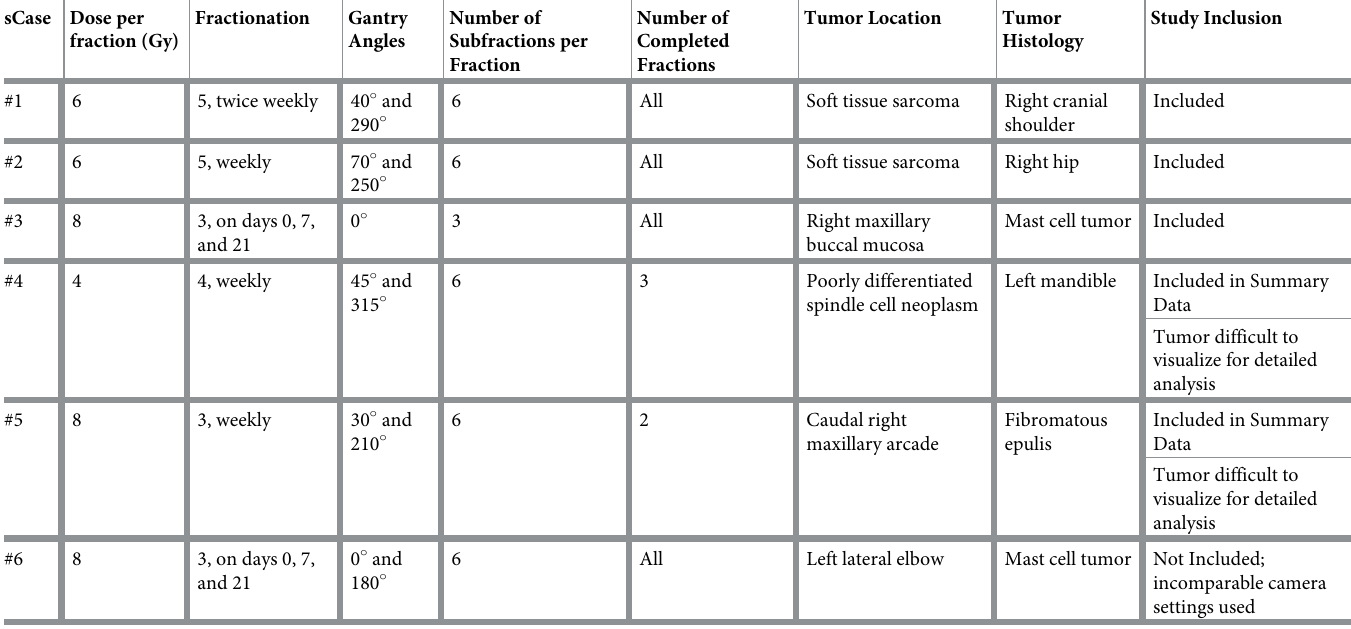
Table 1. Description of canine subjects. Data were acquired from 6 dogs with different cancers and tumor locations; data from 5 of 6 dogs were included in the full analysis. sCase Dose per fraction (Gy)